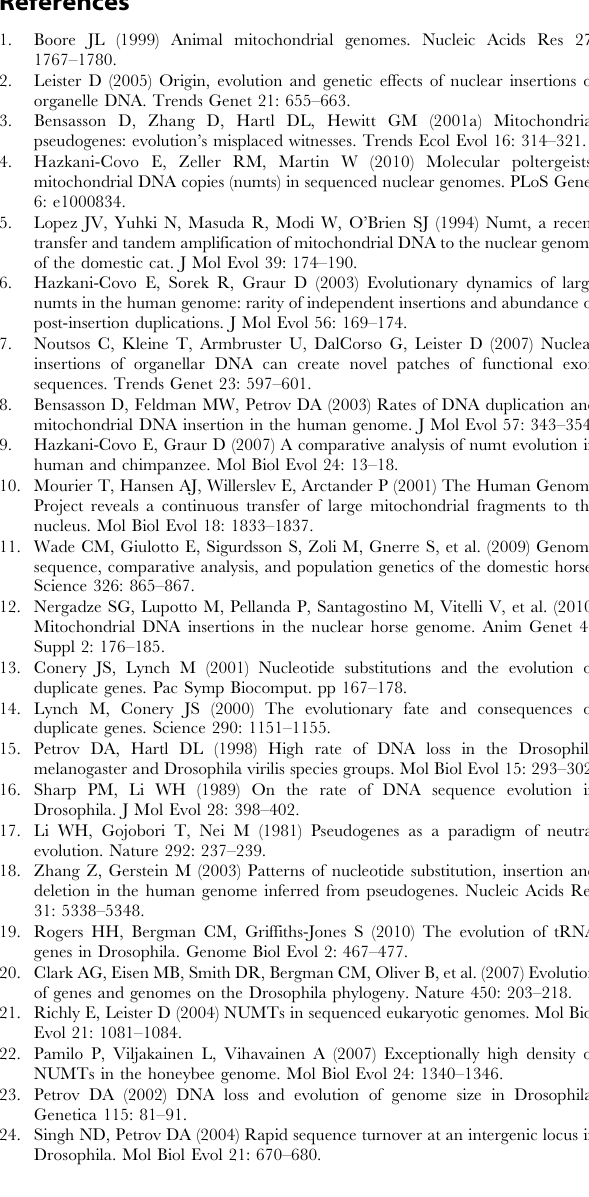
Table S1 List of numts with the coordinates of their nuclear chromosomal locations and their mitochondrial genome origin. Numts that have been merged from multiple separate BLAST hits are represented by the details of individual hits. Table S2 List of paralogous numts within each species. Each row represents a paralog set.